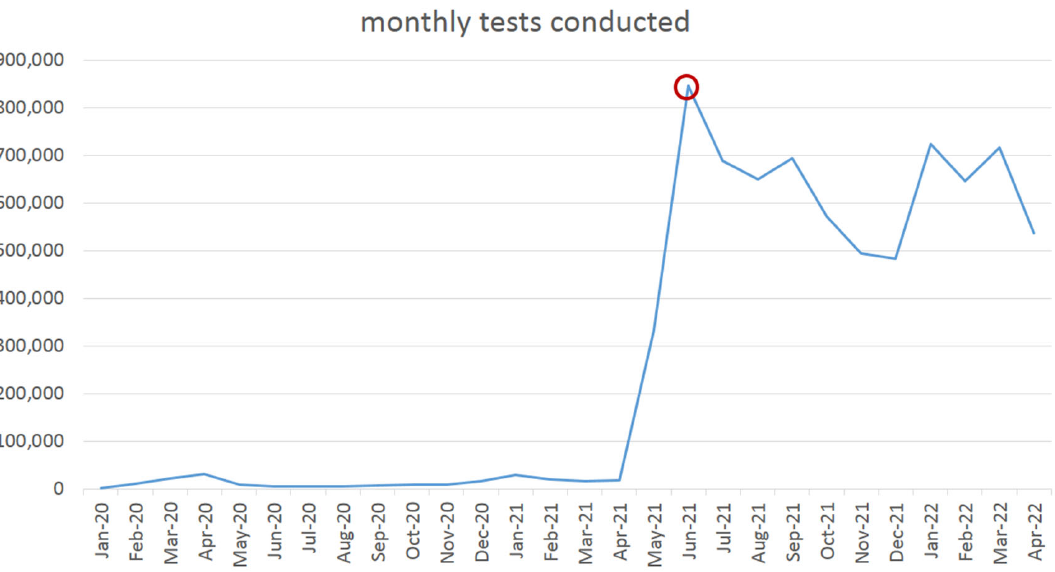
Figure 7. The line chart of monthly tests conducted in Taiwan. Data sources: Taiwan CDC.